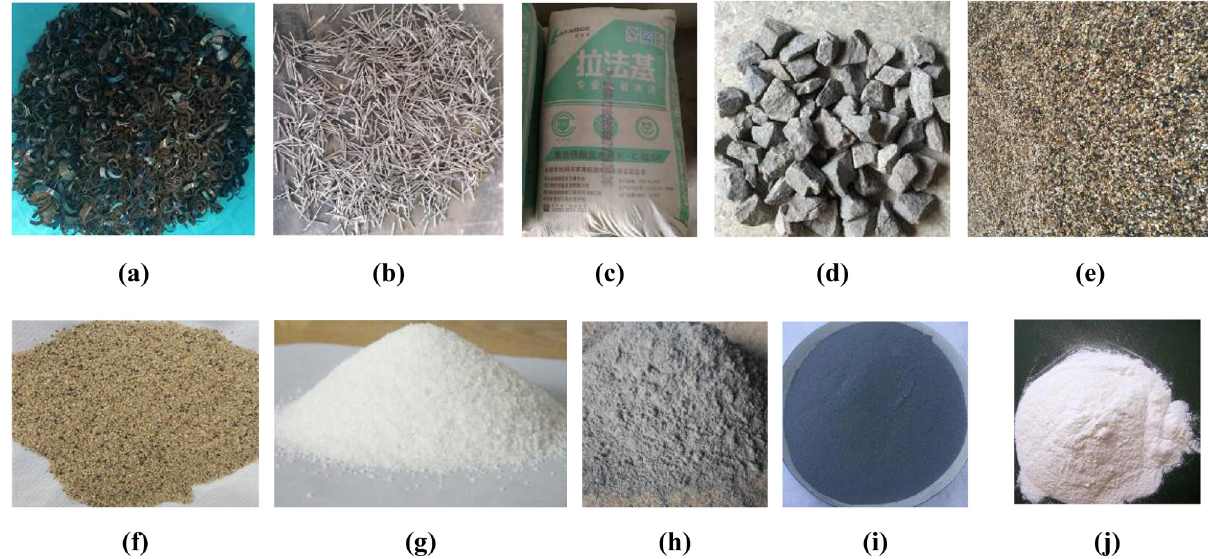
Figure 1: Composition of RSF - reinforced concrete. ( a ) RSF. ( b ) PSF. ( c ) Cement. ( d ) Crushed stone. ( e ) Bean stone ( f ) . Natural sand. ( g ) Quartz sand. ( h ) Fly ash. ( i ) Silica fume. ( j )